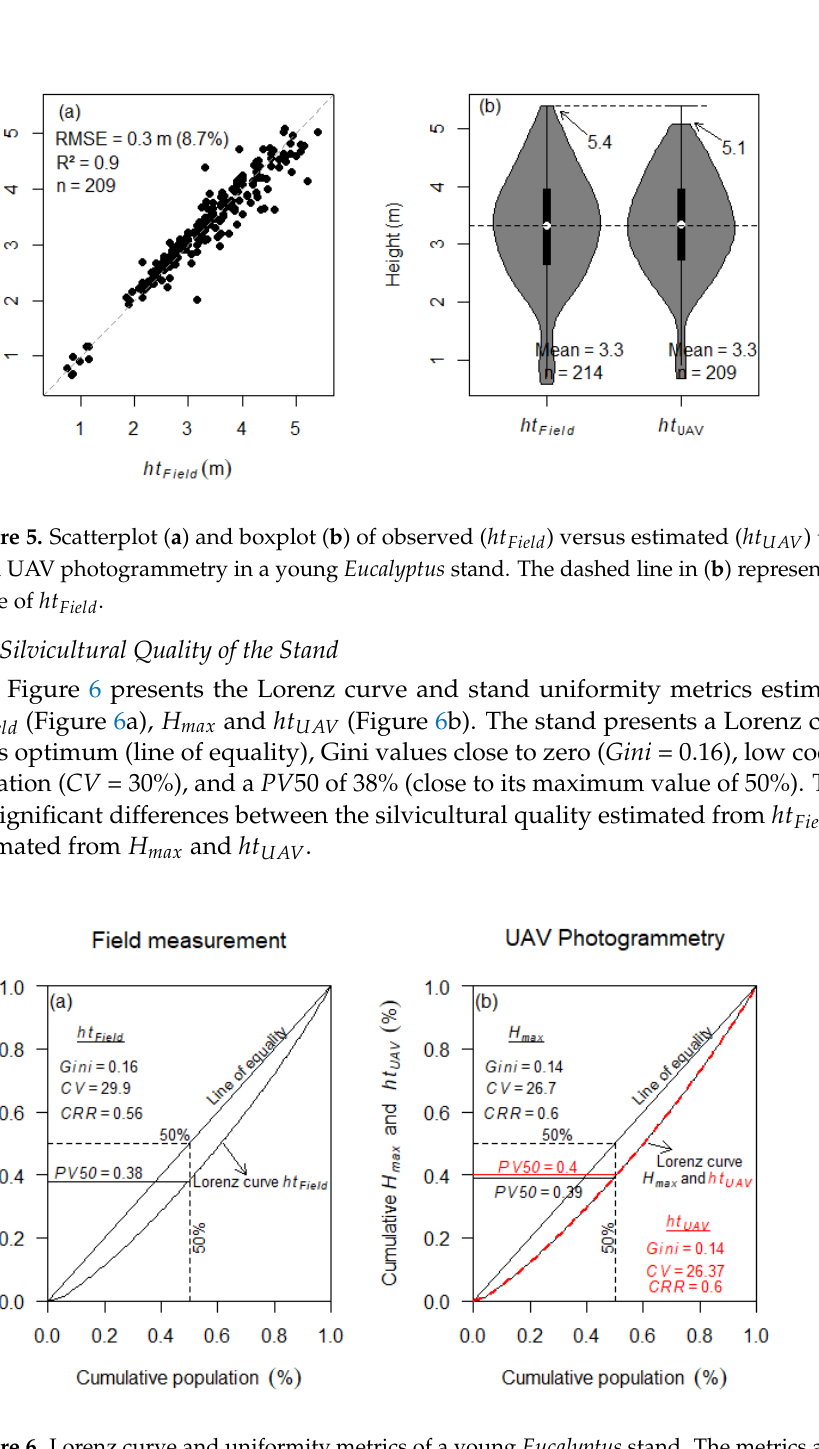
Figure 6. Lorenz curve and uniformity metrics of a young Eucalyptus stand. The metrics are based on tree heights ( ht ) estimated from ( a ) traditional field inventory, and ( b ) UAV photogrammetry data ( H max in black and ht UAV in